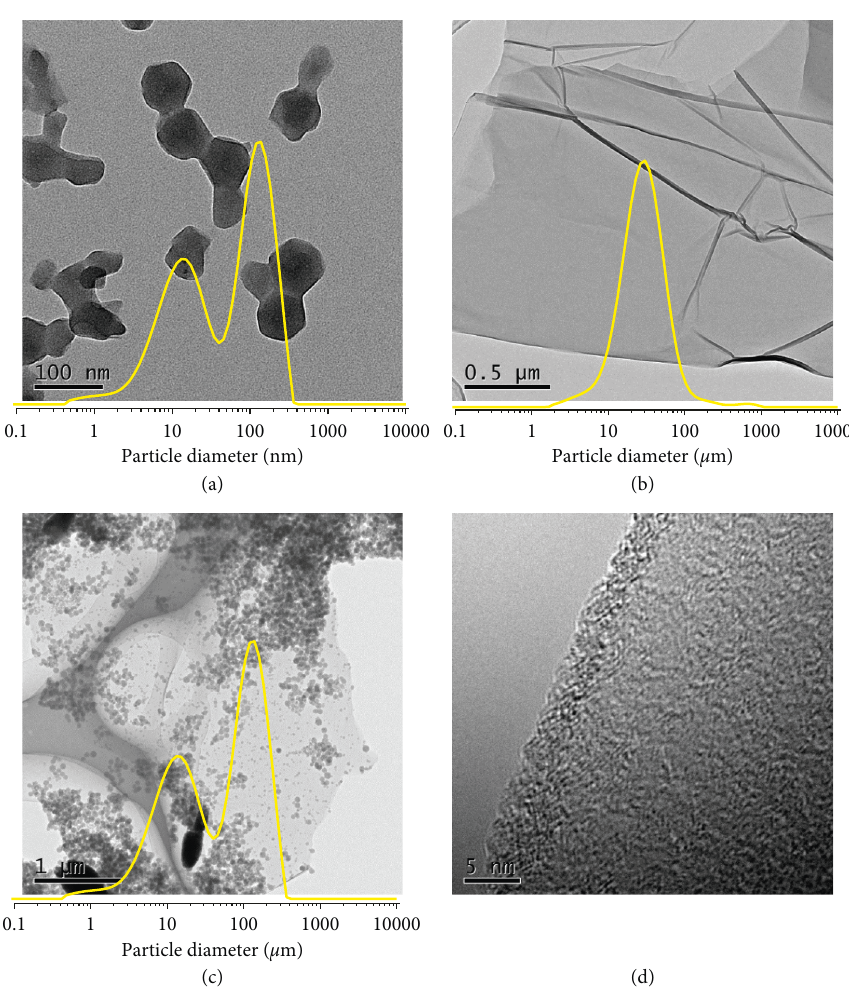
Figure 2: TEM image of different